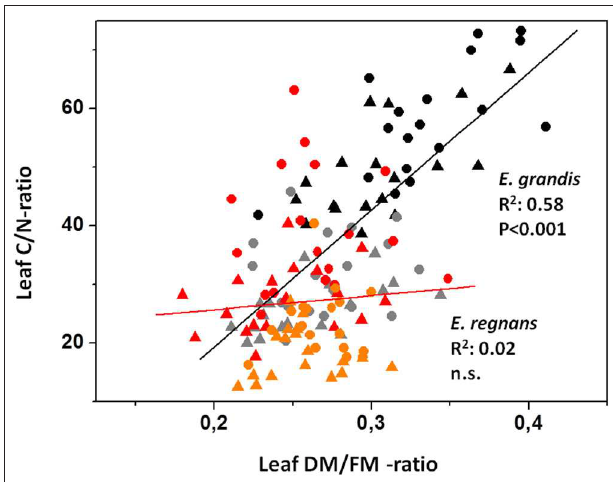
FIGURE 3 | Relation between DM/FM- and C/N-ratios of Eucalyptus leaves. Black symbols : Eucalyptus grandis (mature leaves); gray: E. grandis (young leaves); red: E. regnans (mature); orange: E. regnans (young); circles: low N-addition; triangles: high N-addition. For E. grandis , correlation analysis included gray and black symbols ( N = 72); and for E. regnans orange and red symbols ( N = 72). above results differ slightly, if respiration is expressed per unit fresh mass ( Table S4 ).